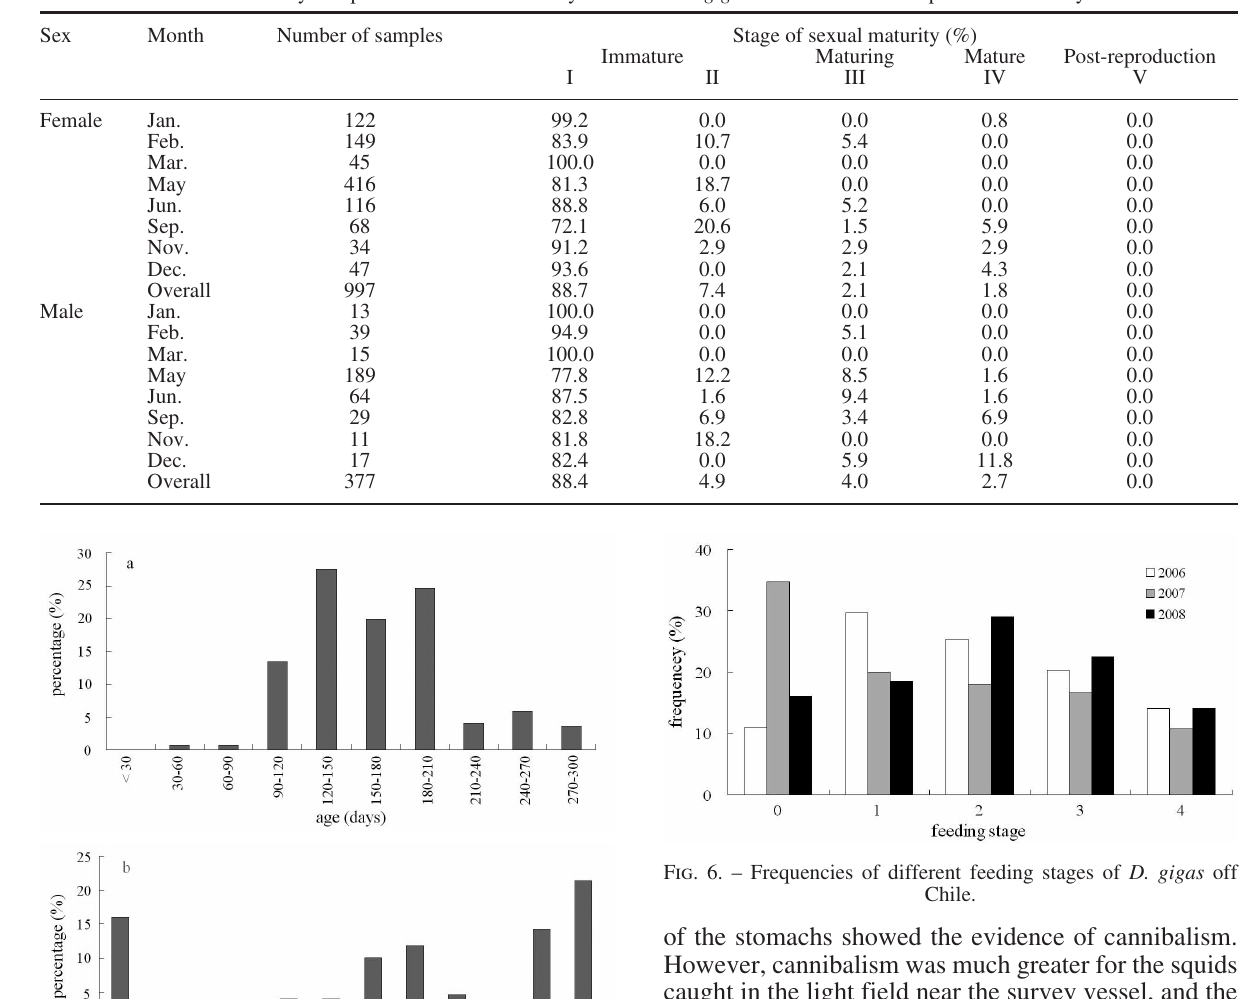
Table 4. – Monthly composition of sexual maturity for Dosidicus gigas off Chile between April 2006 and May 2008.